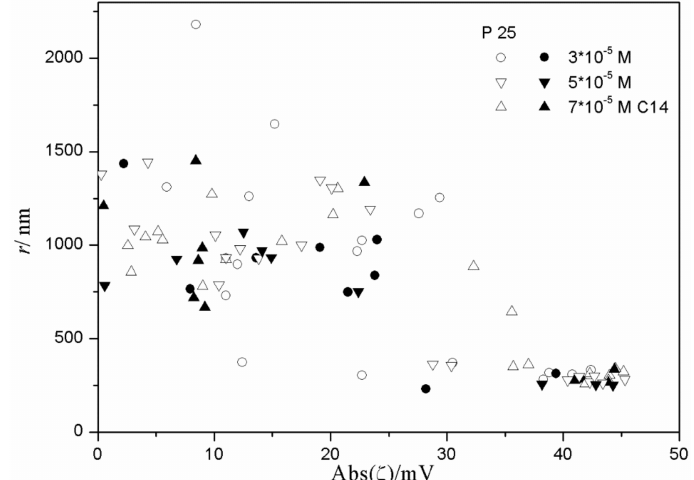
Figure 12. The particle size as a function of | ζ | in fresh (white points) and aged (black points) dispersions of titania in the presence of sodium